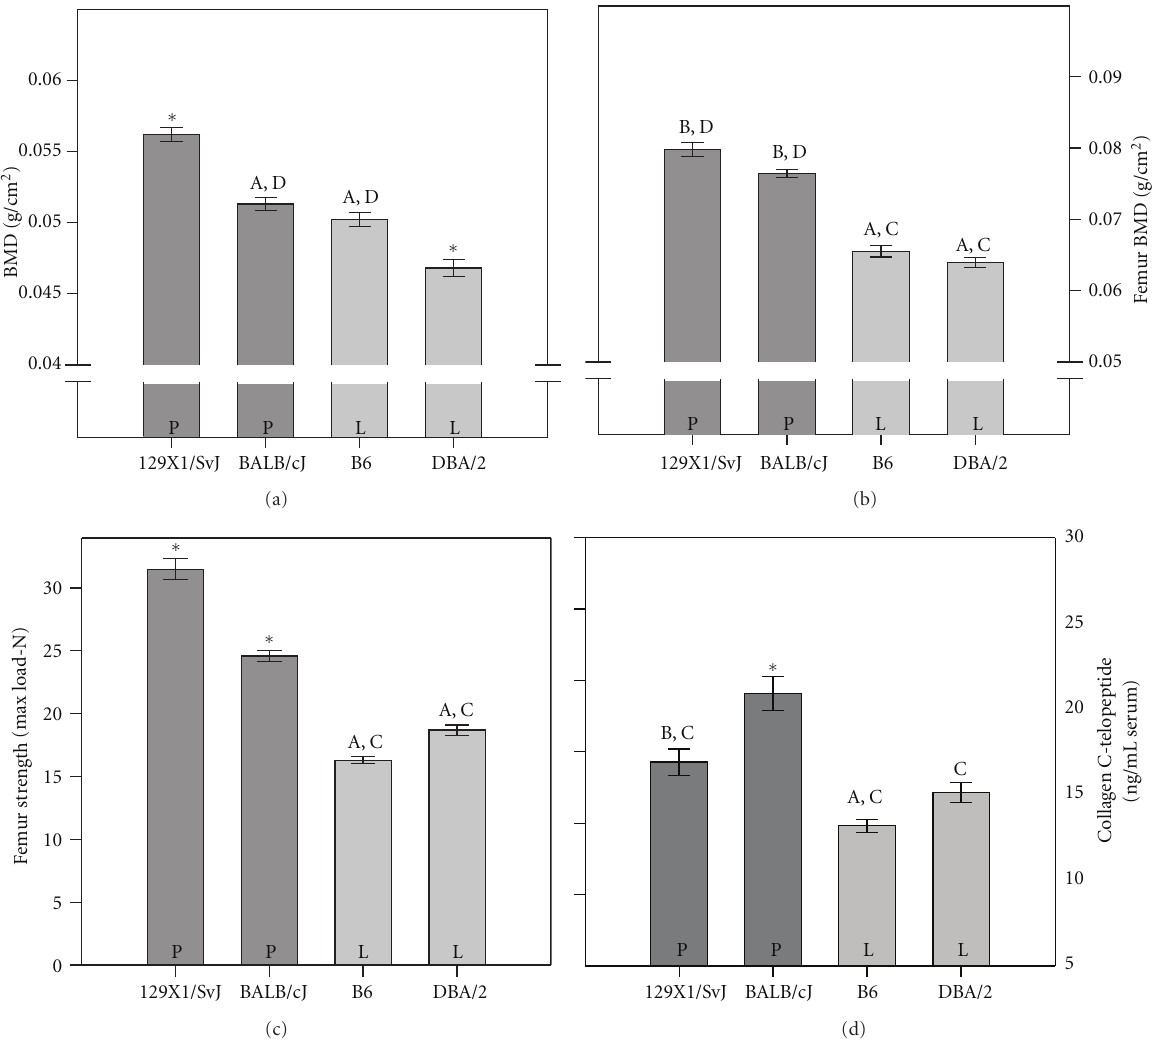
Figure 1: Bone parameters in the 129X1/SvJ, BALB/c, B6, and DBA/2 inbred strains. Significant di ff erence between the strains at the P < 0 . 05 level is indicated with asterisks when di ff erent from the three other strains, with A when di ff erent from 129X1/SvJ, with B when di ff erent from B6, with C when di ff erent from BALB/cJ, and with D when di ff erent from DBA/2. P451L genotype indicated as P or L at each strain. (a) In BALB/c and B6 whole body BMDs were not significantly di ff erent from each other, but significantly lower than 129X1/SvJ and BALB/cJ. BALB/cJ had higher BMD than DBA. (b) The femoral BMD in 129X1/SvJ and BALB/cJ were significantly higher than B6 and DBA/2. The latter were not significantly di ff erent from each other. (c) The femoral strength assessed by a three-point bending test showed significantly higher strength in 129X1/SvJ femurs. BALB/c had stronger femurs than the DBA and B6 strains had. The latter two were not significantly di ff erent from each other. (d) The serum concentration of the resorption marker s-CTX-I, showed significantly higher resorption in the BALB/cJ strain and lowest in the B6